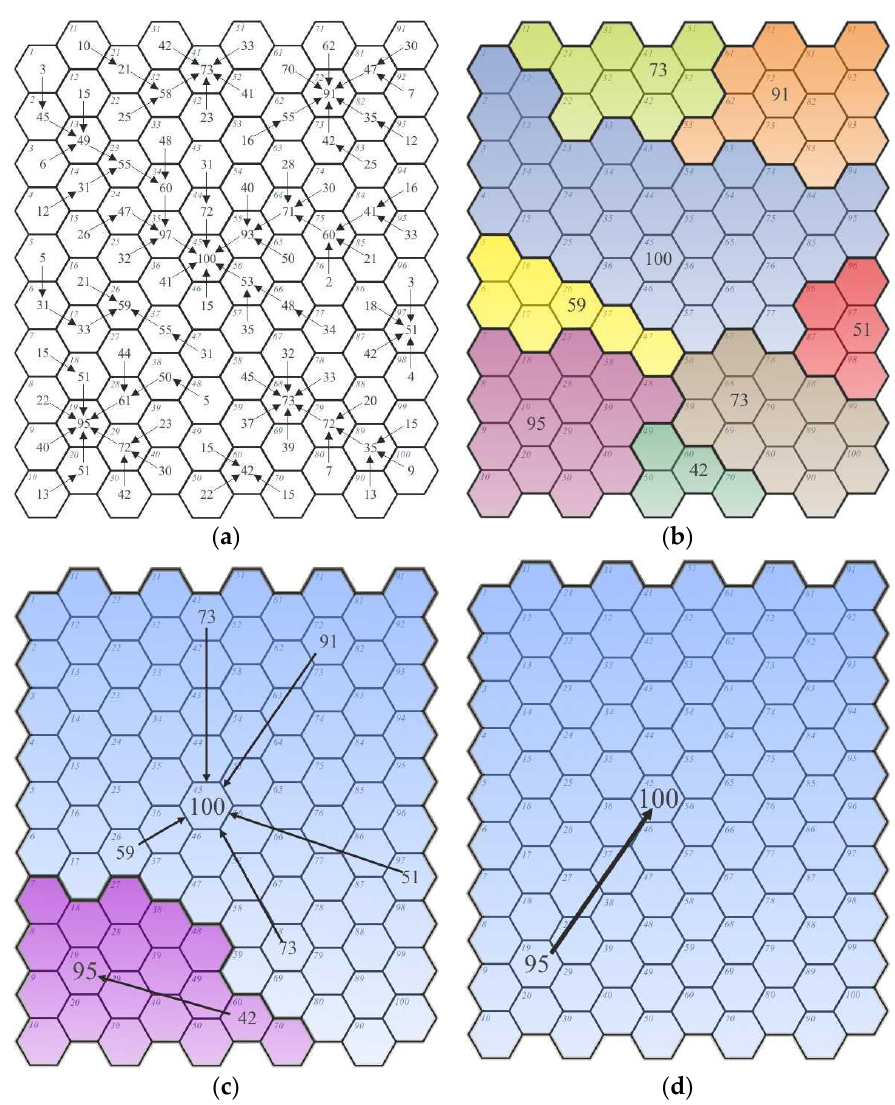
Figure 6. The levels of emergence of networks and new spatial regions according to the maximum value increase path: ( a ) the stage of revealing the minimum value increase relationship; ( b ) the first stage of value aggregation; ( c ) the second stage of value aggregation; ( d ) the third stage of value aggregation. Source: Own analysis.